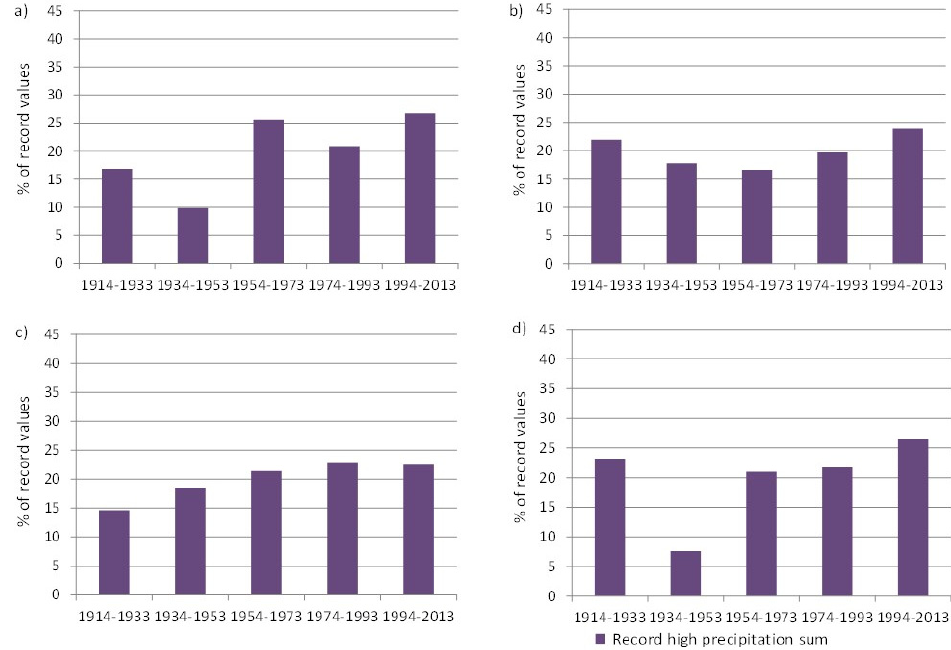
Figure 5. The total proportion of extremely high daily precipitation (99th percentile of daily precipitation sum defined separately for each weather station) observed in 20-year study intervals in northern Fennoscandia. ( a ) January, ( b ) April, ( c ) July, and ( d ) October.